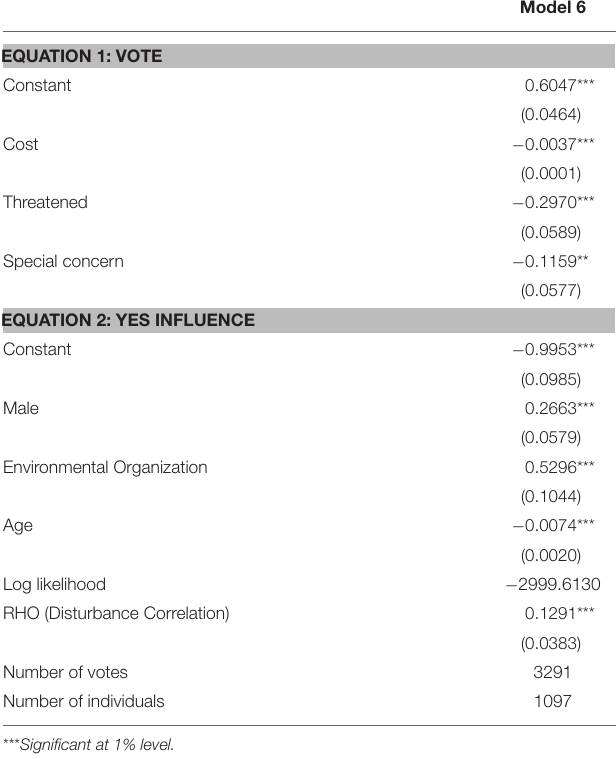
TABLE 5 | Bivariate probit model.